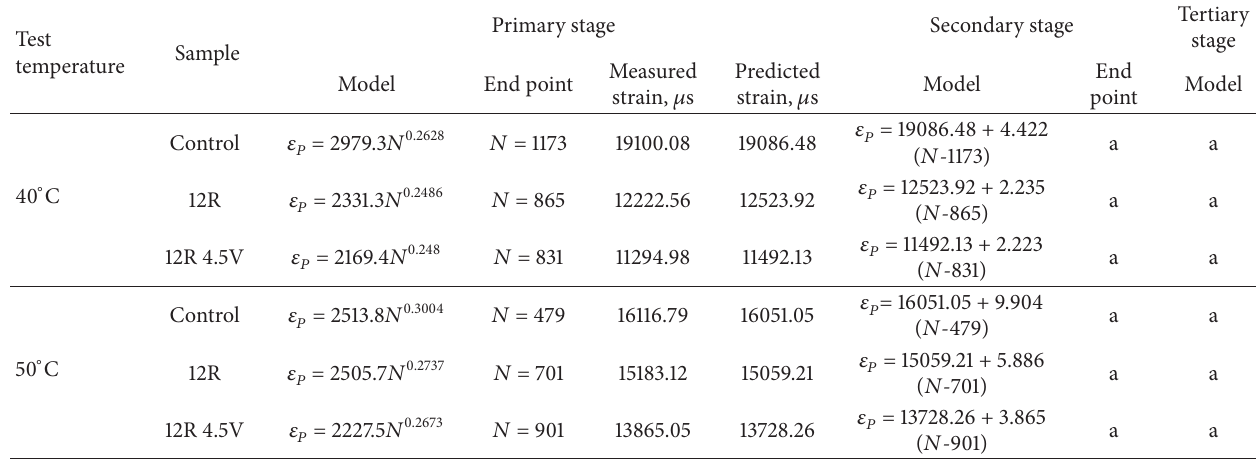
Table 7: Three-stage models and boundary points for control and modified mixtures at 200 kPa stress.